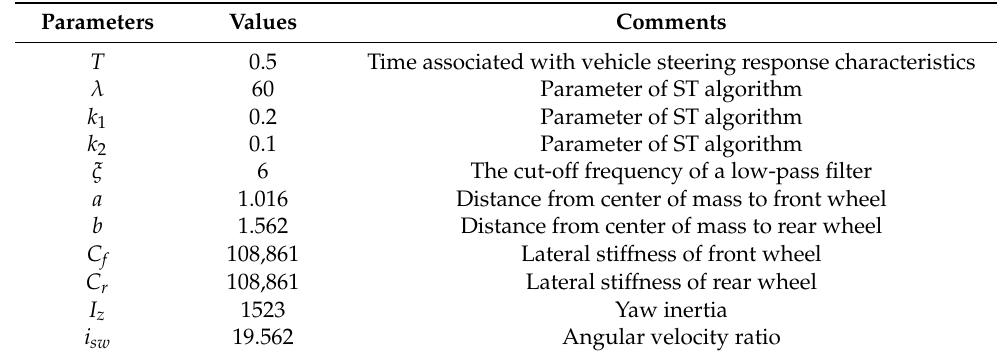
Table 1. Parameters of ST